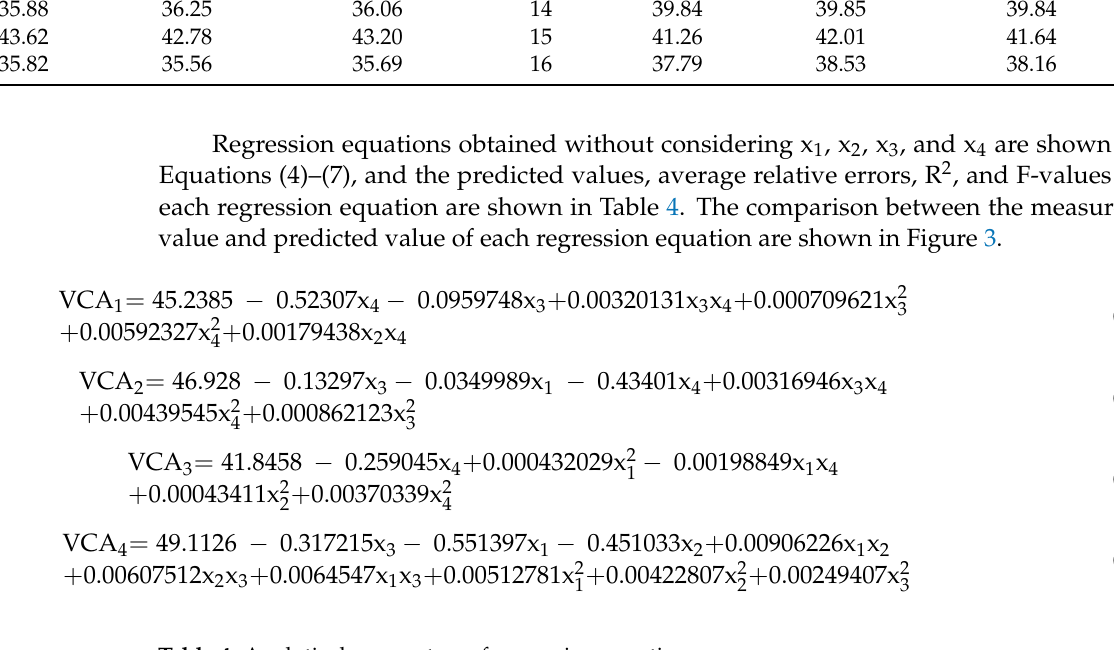
Table 4. Analytical parameters of regression equations. Regression Equation